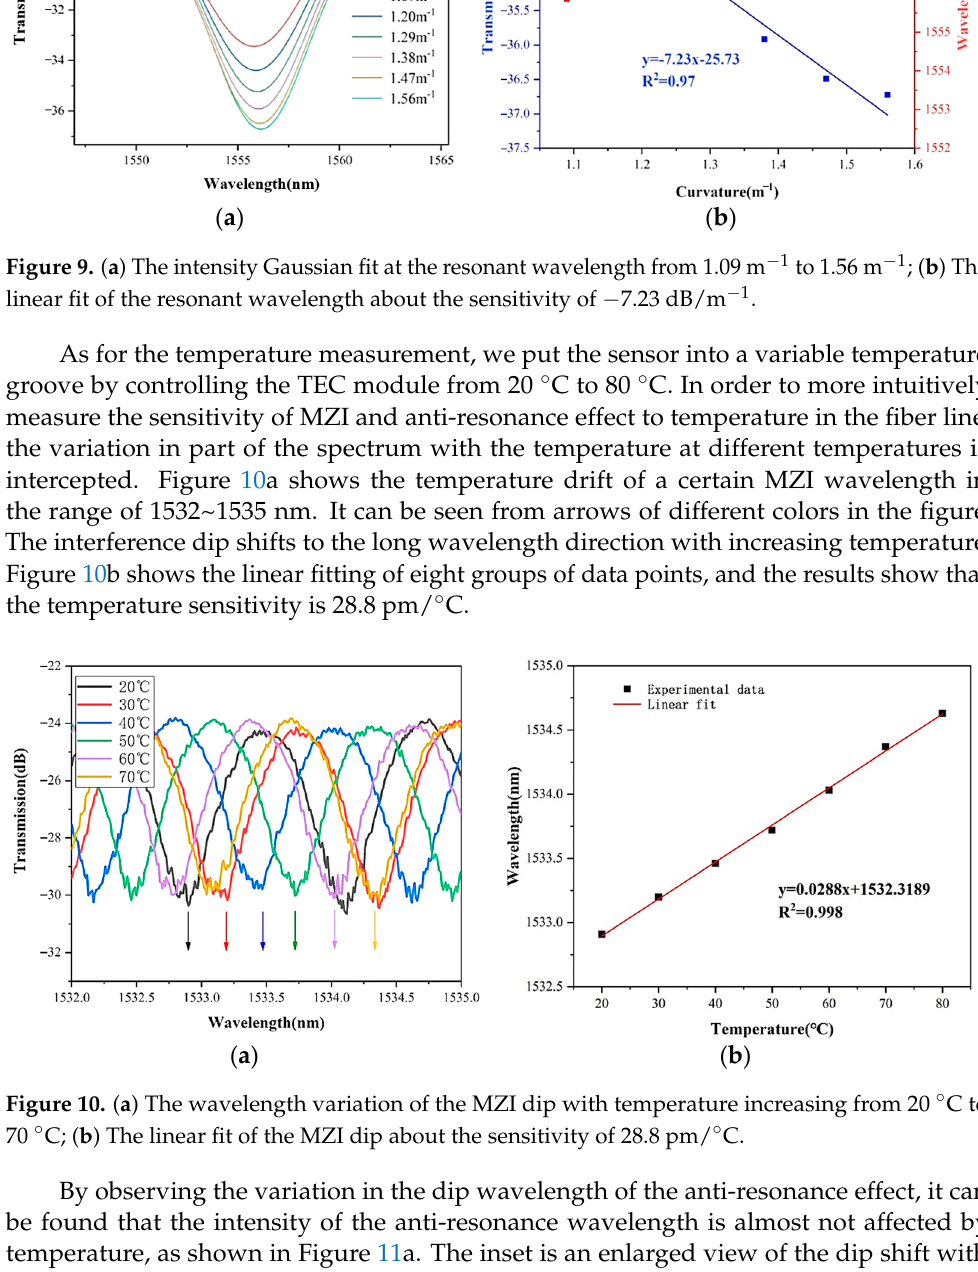
ter wavelength drift of the light source.